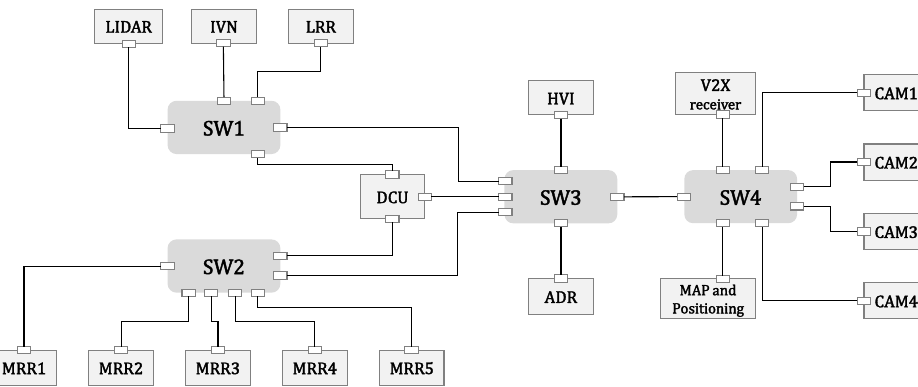
Figure 8. Network topology used for the performance evaluation of the genetic-algorithm-based TSN optimal schedule algorithm. LRR, long-range radar; DCU, domain control unit; CAMn, camera # n ; MRR, mid-range radar; IVN, gateway for in-vehicle network; ADR, automatic data recorder; MAP, map and positioning; V2X, vehicle to infrastructure; HVI, human-vehicle interface.